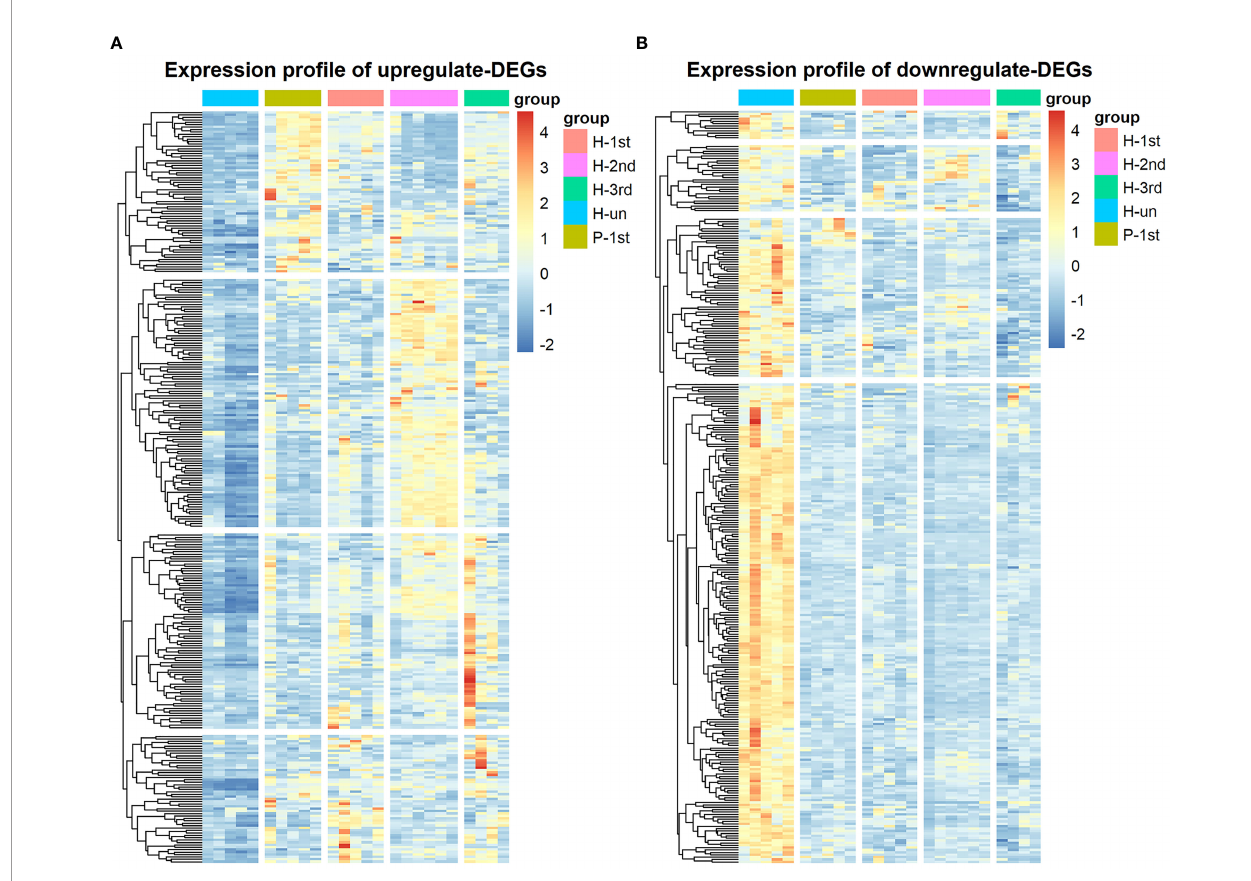
FIGURE 3 | Hierarchical cluster analysis of DEGs in fi ve groups. (A) The expression pro fi le of 304 up-regulate DEGs. (B) The expression pro fi le of 309 down- regulate DEGs. Each row represents mRNA and each column represents a sample. Orange indicates higher expression and blue indicates low expression in vaccination groups as compared with that in H-un